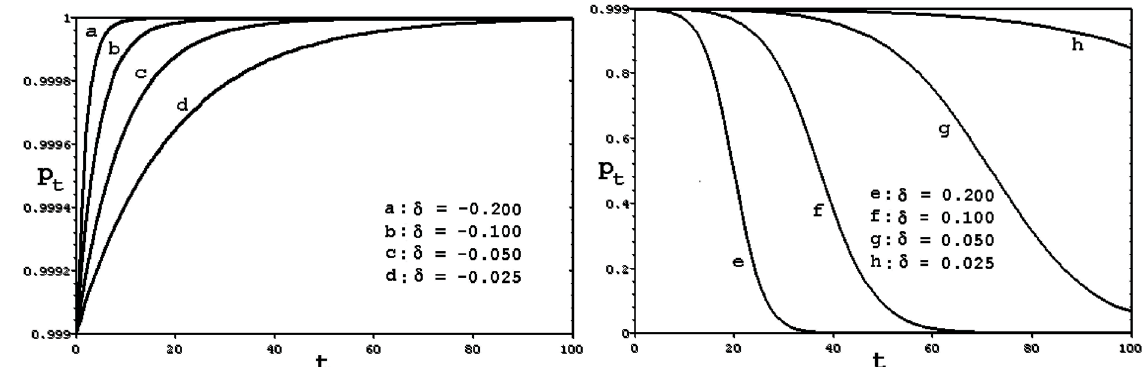
Figure 2 ‒ Evolution of the wild type allele that determines the usual male population proportion; when the mutant allele on the Y chromosome determines a male progeny frequency larger than c, the normal allele is eliminated from the population; when the mutant allele produces a male progeny smaller than c, the mutant allele is eliminated so that the c population frequency of males is restored (model